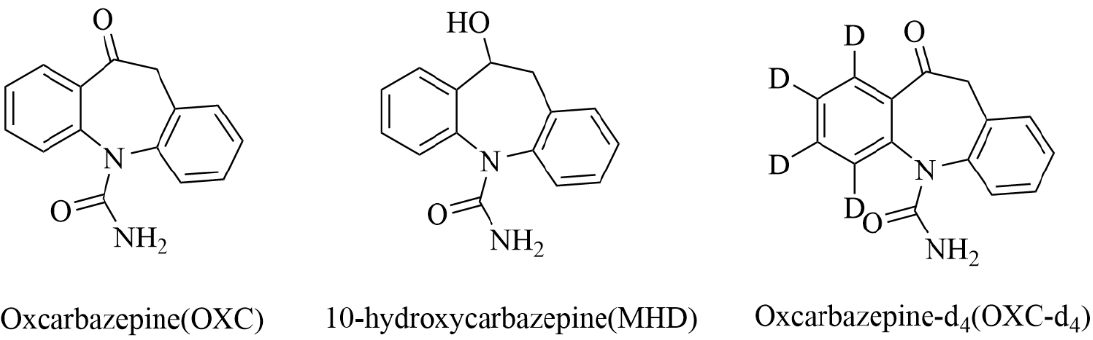
Figure 1. Structures of oxcarbazepine (OXC), 10-hydroxycarbazepine (MHD) and oxcarbazepine-d 4 (OXC-d 4 , internal standard).